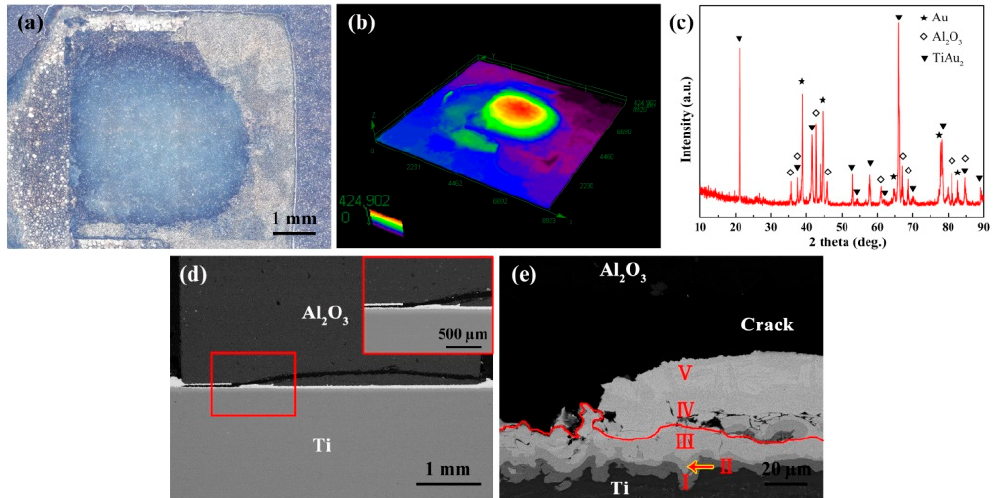
Figure 9. Fracture analysis of titanium/Au/Al 2 O 3 joints brazed at 1115 °C for 1 min after the shear test. ( a ) Fracture surface of Ti alloy side, ( b ) 3D image of ( a ), ( c ) XRD pattern of ( a ), ( d ) fracture path of the Ti/Au/Al 2 O 3 joint, and ( e ) high-magnification image of ( d ).